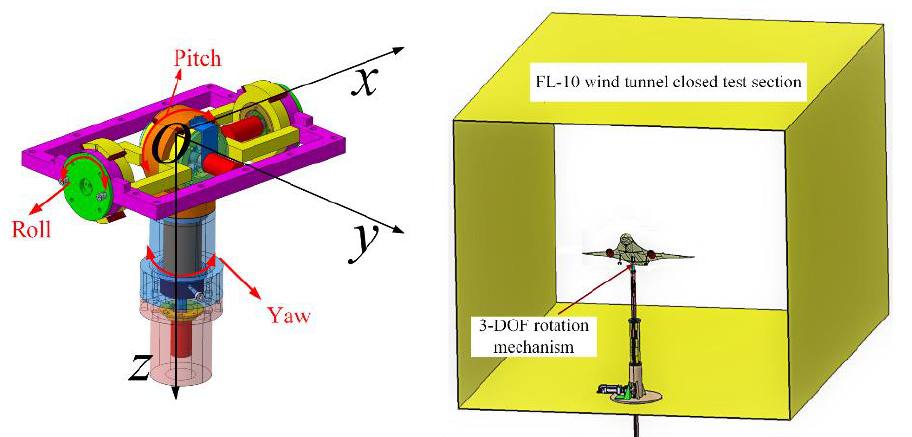
Figure 2. The 3-DOF rotation mechanism. Figure 2. The 3‑DOF rotation mechanism. Table 1. Measurable data from wind tunnel virtual flight